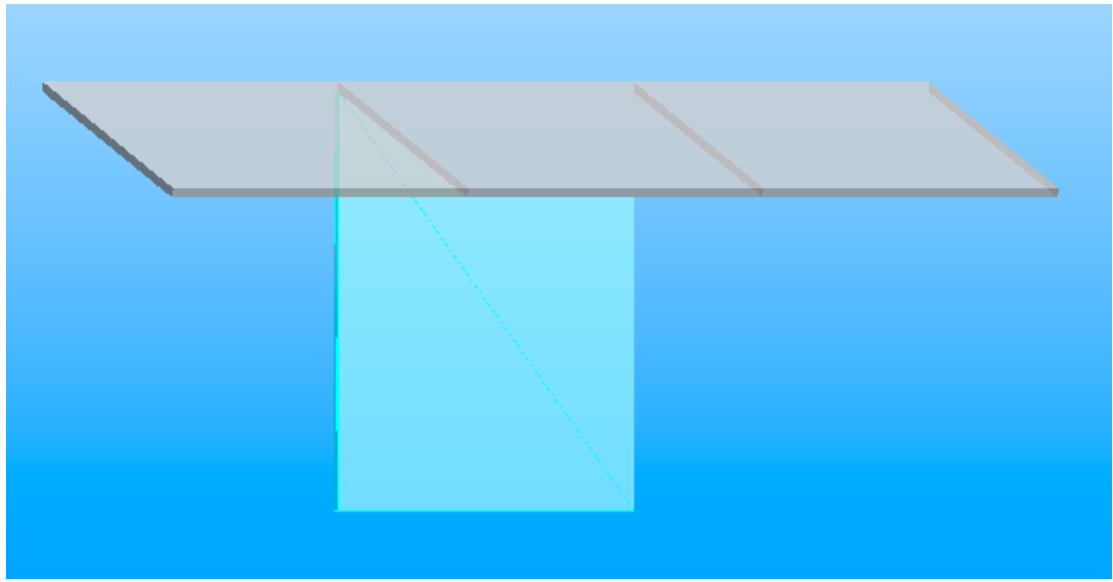
Figure 14. SC2 calculation by using the proposed digital method.